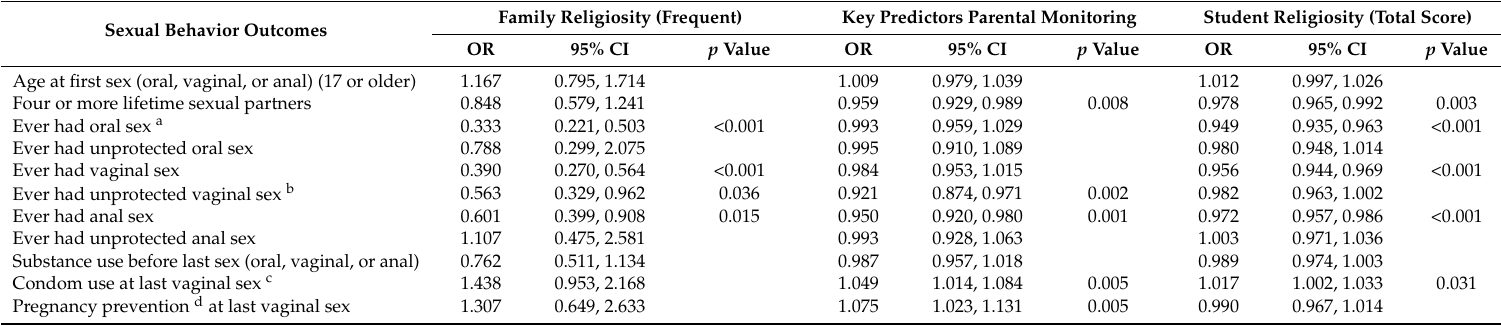
Table 3. Unadjusted associations between family religiosity, parental monitoring, and student religiosity and emerging adults’ sexual behaviors ( n = 608). Family Religiosity (Frequent) Key Predictors Parental Monitoring Student Religiosity (Total Score) Sexual Behavior Outcomes OR 95% CI p Value OR 95% CI p Value OR 95% CI p